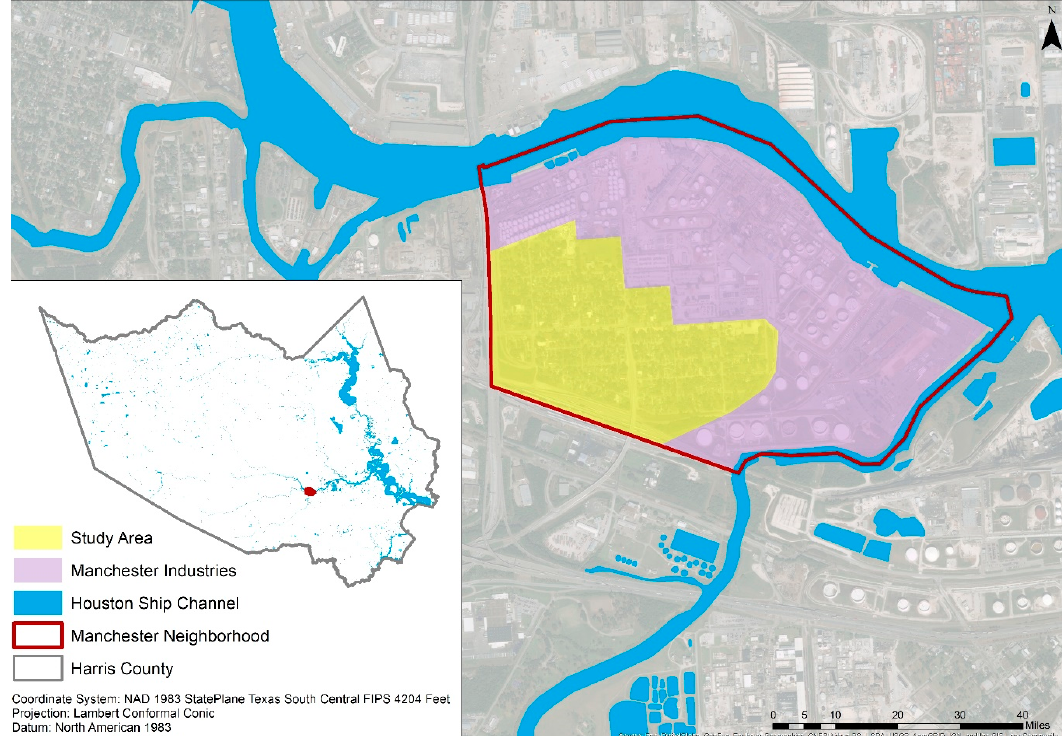
Figure 1. Location of the Manchester neighborhood in Houston, Texas .